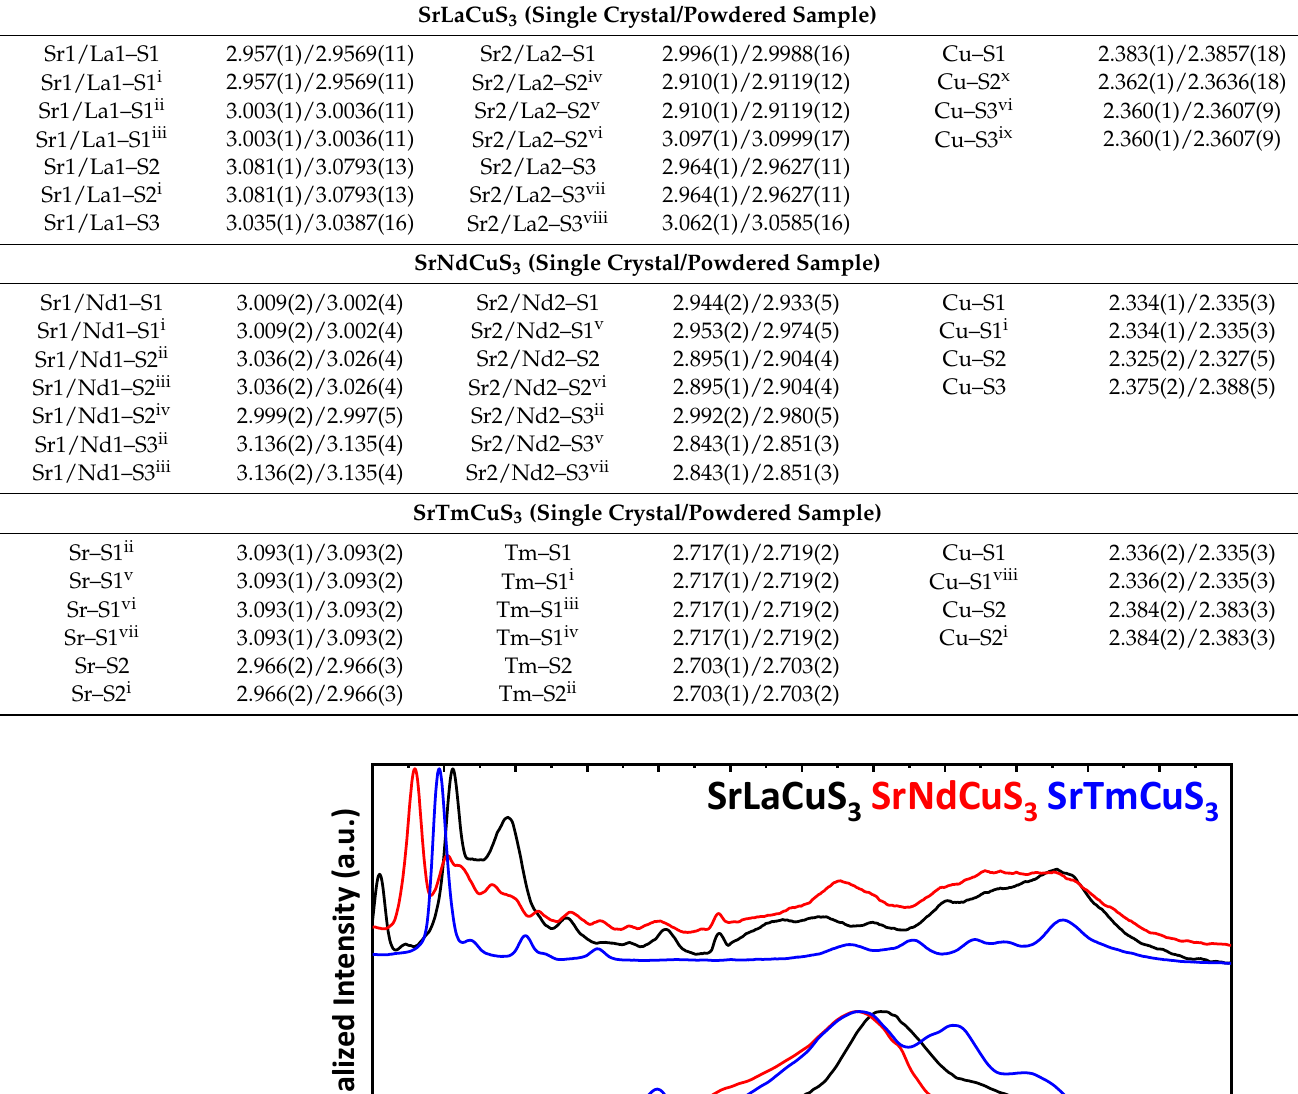
Table 4. Bond lengths (Å) in the crystal structures of SrLnCuS 3 (Ln = La, Nd, Tm). For symmetry codes see Figure 1.